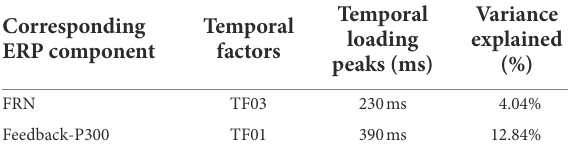
TABLE 2 PCA factors selected for statistical